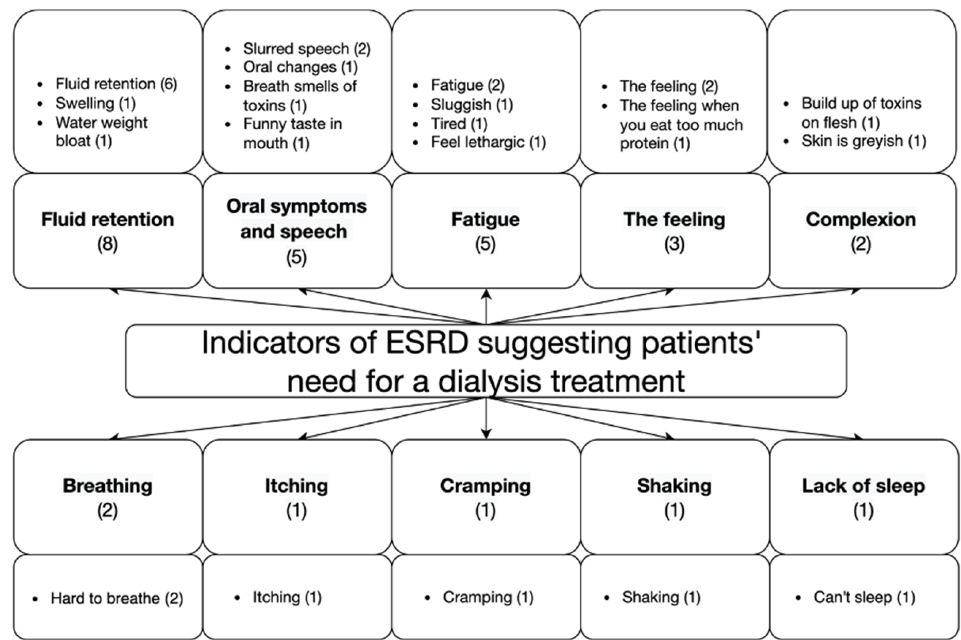
Figure 2. Categories and keywords related to patients’ and care partners’ awareness of indicators of ESRD suggesting patients’ need for dialysis treatment. The number in parentheses next to each category indicates the number of times a related keyword or comment was mentioned by a participant.